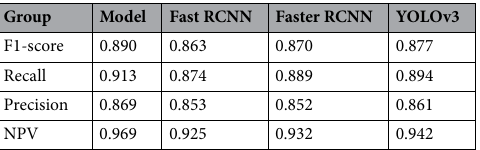
Table 4. The comparison of the performance between our Rib Fracture Detection System with Fast RCNN, Faster RCNN,